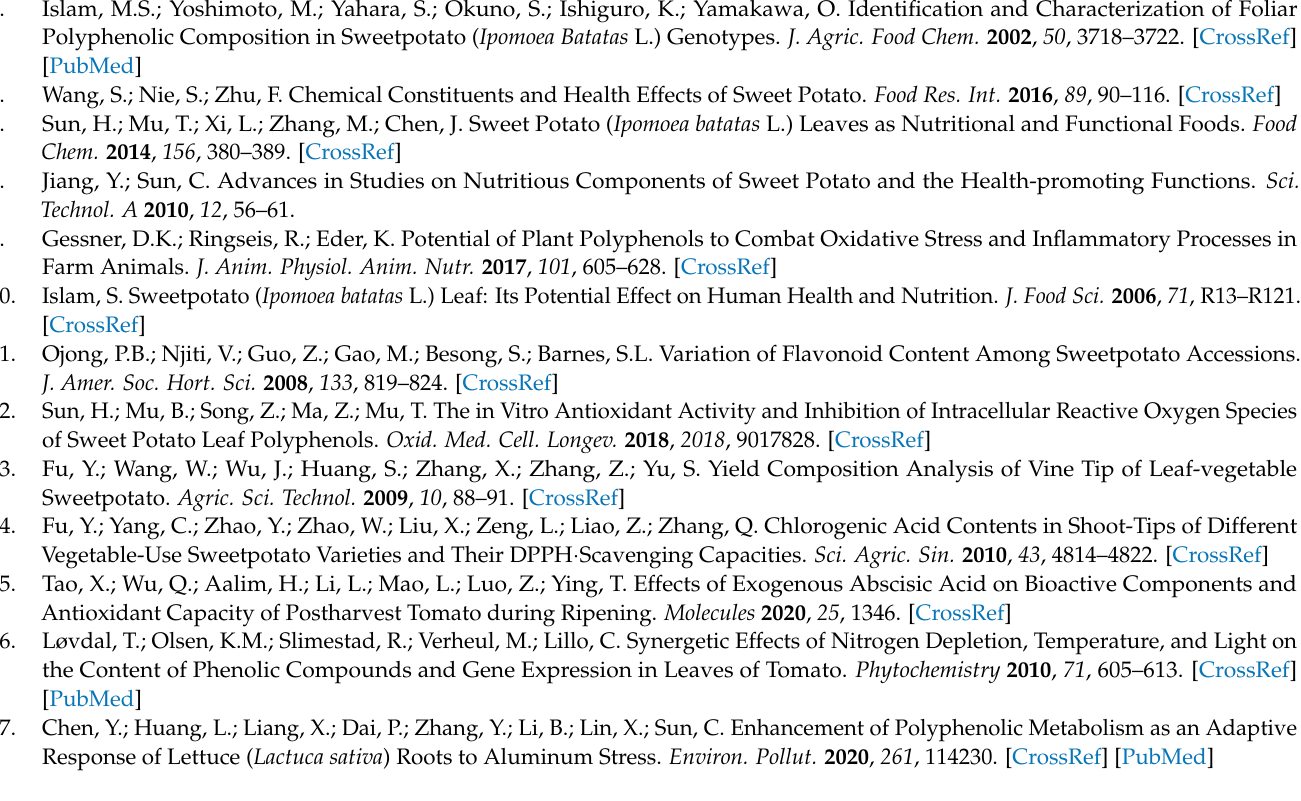
Table S4: Upregulated genes and annotation of the phenylpropanoid biosynthetic